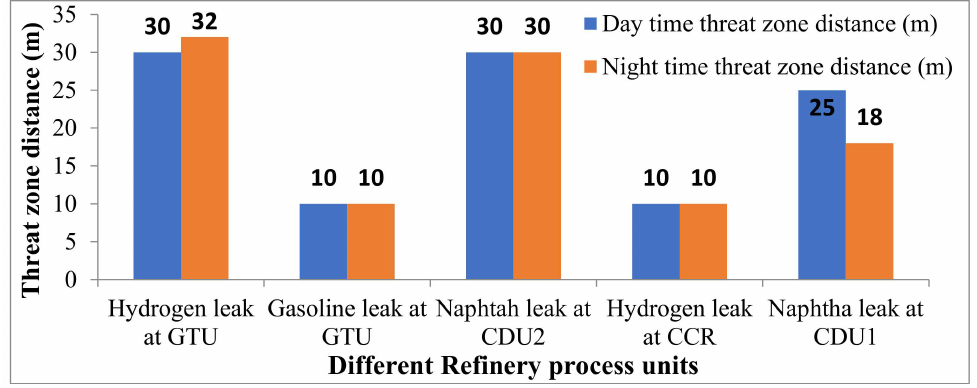
Figure 5. Threat zones for jet